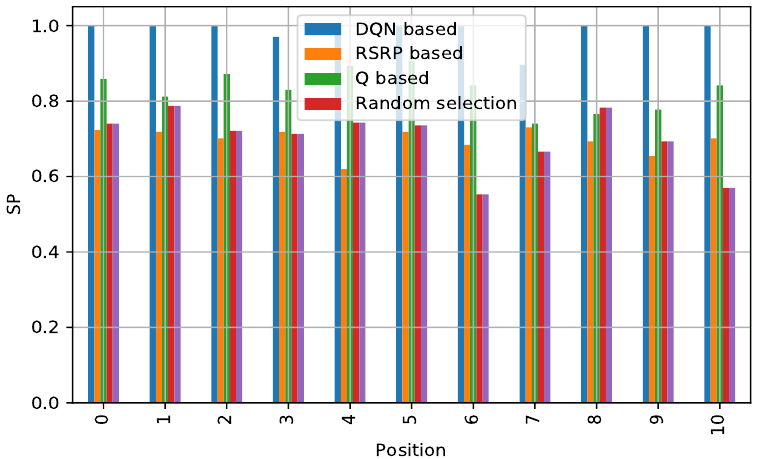
Figure 6. Comparison of successful access probability: DQN-based vs. others in random access network